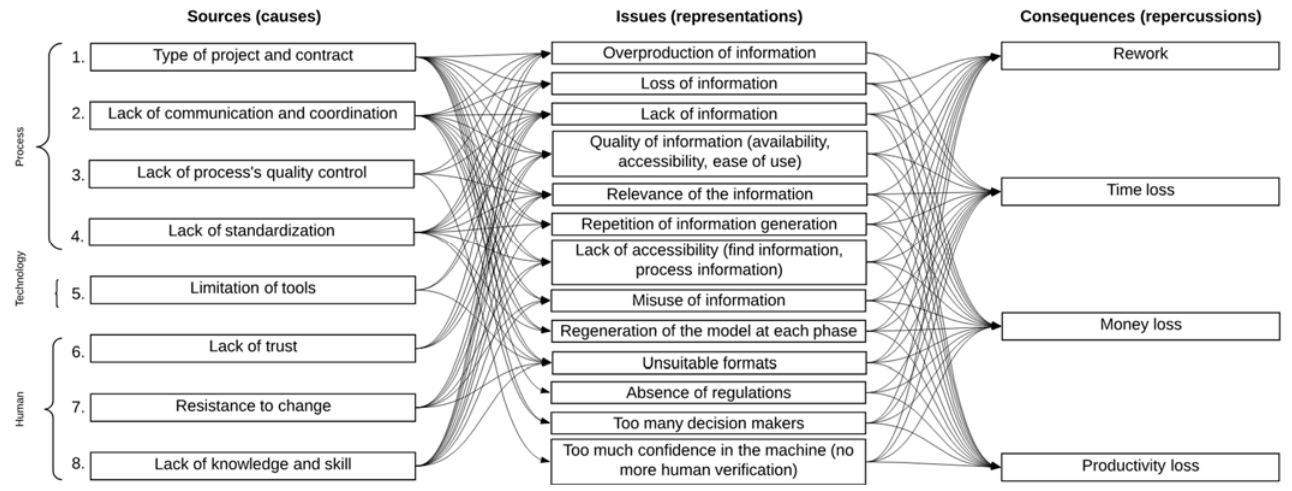
Figure 3. Link between sources, issues and consequences of waste in information flows.